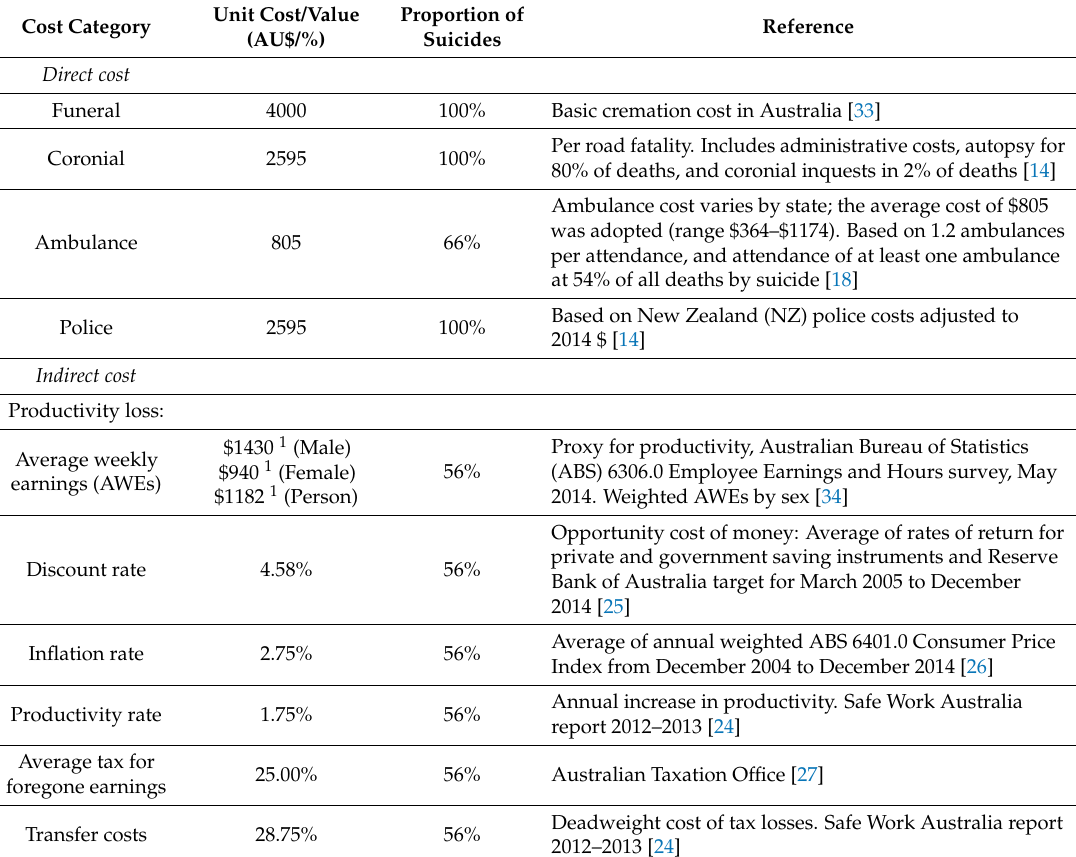
Table 1. Summary of key cost